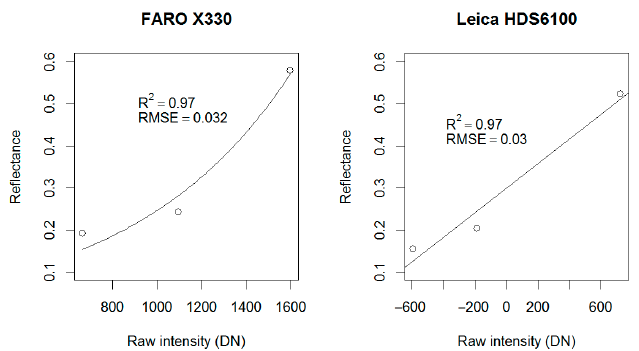
Figure 3. Raw intensity measurements presented against measured reflectance of the Spectralon reflectance panels (50%, 25%, 12%) with the regression models, and respective coefficient of determinations (R 2 ) and root mean square errors (RMSE), between raw intensity (digital number, DN) and reflectance for the FARO and Leica scanners, respectively.